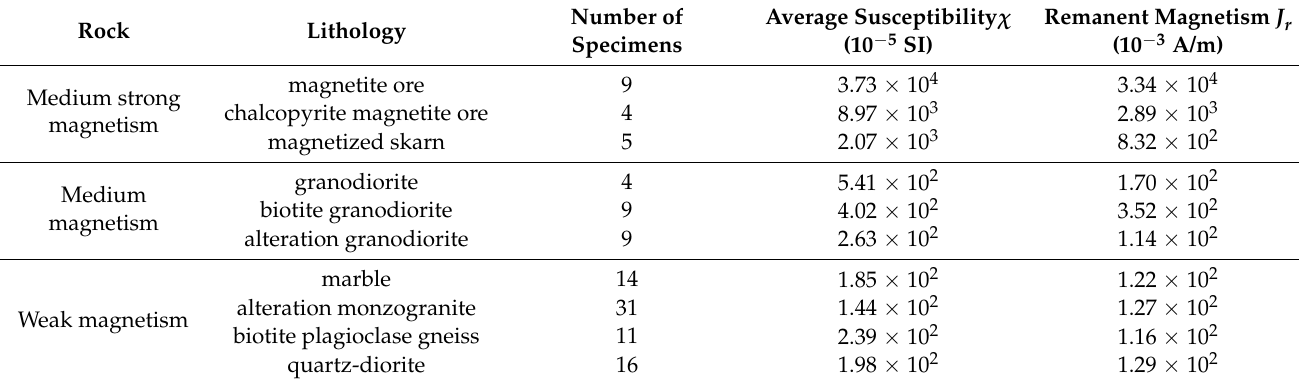
Table 1. Magnetic parameters of minerals and rocks in the Zaohuoxi research area [64].